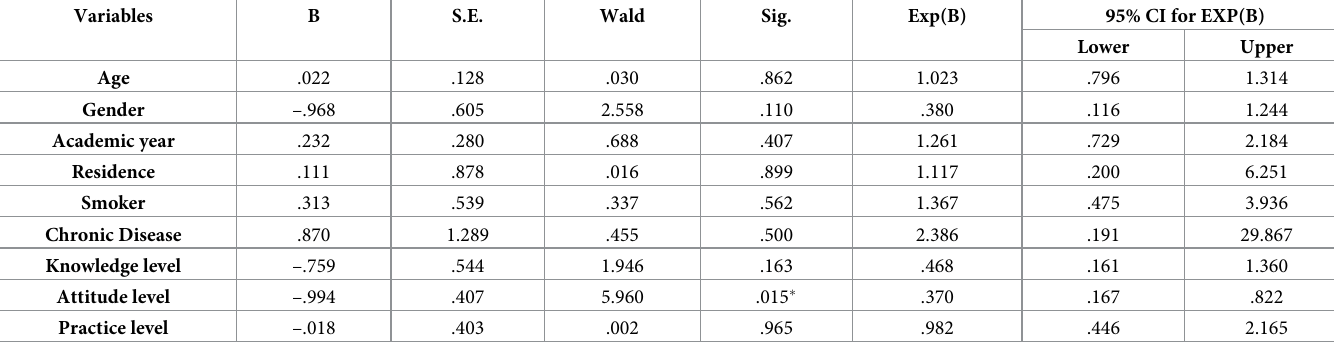
Table 7. Logistic regression of independent predictors of the frequency of COVID-19